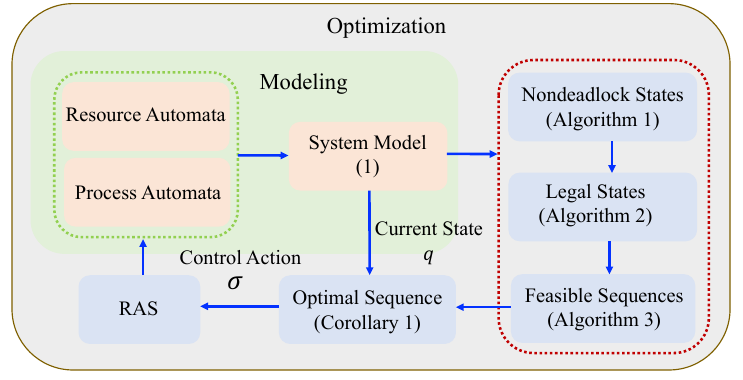
Figure 4. The implementation process of the proposed